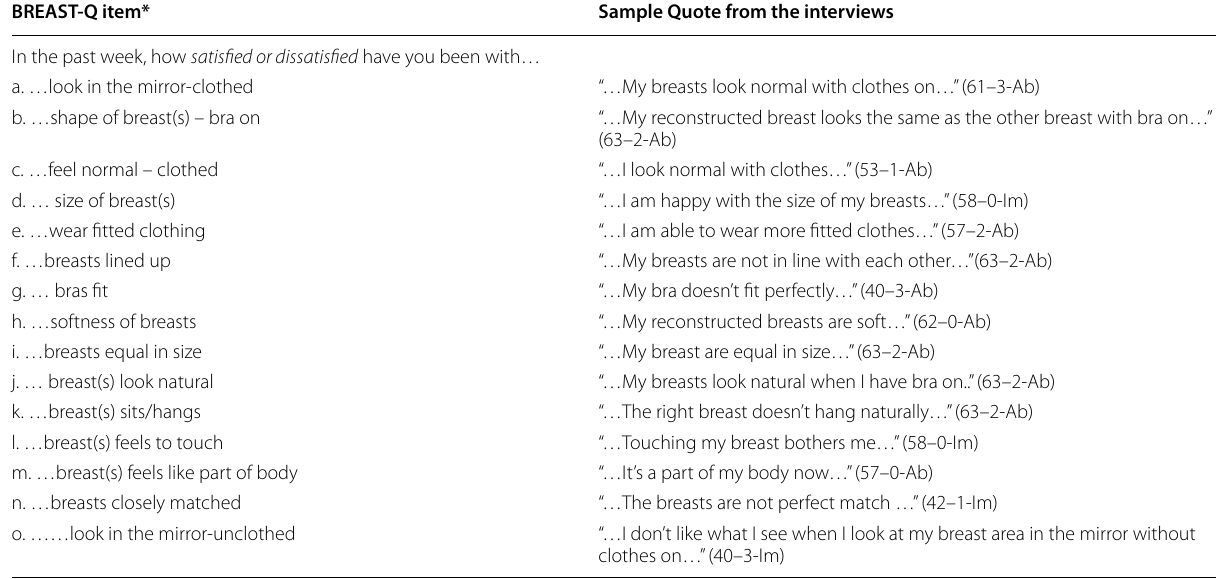
* BREAST-Q items have been abbreviated. For a review copy of the BREAST-Q Satisfaction with Breasts scale, please visit www. qport folio. org Participant – Age-Stage of Breast Cancer-Type of Reconstruction, Ab- Abdomen based,